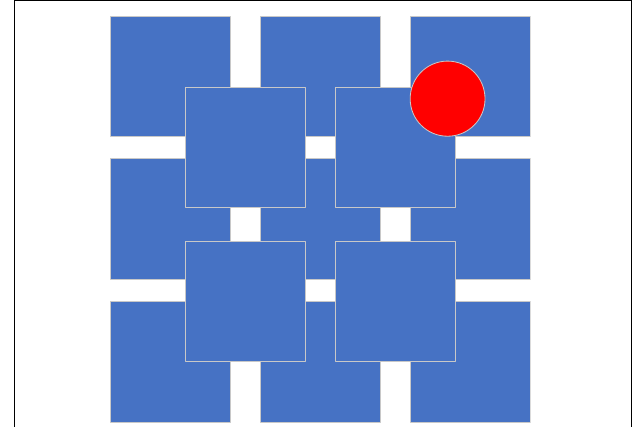
FIGURE 3 | Example of the Von Restorf effect.